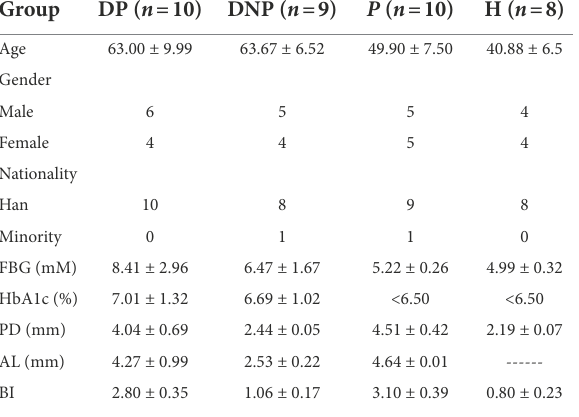
TABLE 2 Demographic and clinical characteristics of subjects.